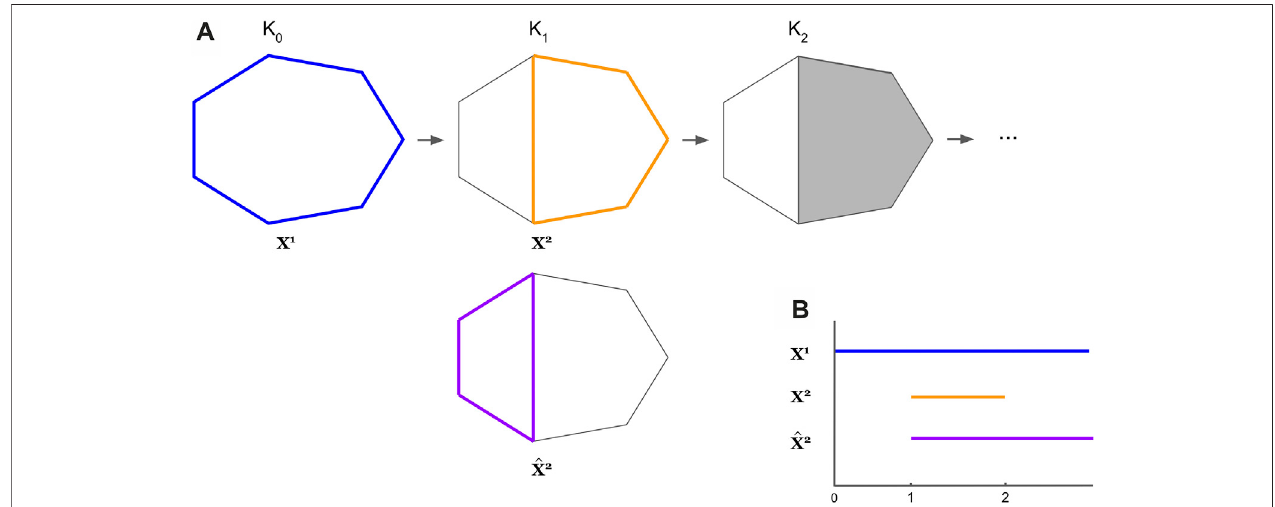
FIGURE 4 | An example where the optimal cycles obtained from Eq. 8 do not form a persistent homological cycle basis. The thickened colored cycles in Sub fi gure (A) represent a cycle representative for the hole it encloses, and the bar with the corresponding color in Sub fi gure (B) records the lifespan of the cycle. In Sub fi gure (A) , we see L ( x 1 ) (cid:2) [ 0 , ∞ ) , L ( x 2 ) (cid:2) [ 1 , 2 ) Then, { x 1 , x 2 } formsabasisforthepersistenthomologicalcycles.Thecyclerepresentative (cid:9) x 2 isanoptimalcyclerepresentativeobtainedbysolving Eq. 7 for the fi ltered simplicial complex K 2 . However, L ( (cid:9) x 2 ) (cid:2) [ 1 , ∞ ) , and thus { x 1 , (cid:9) x 2 } is no longer a persistent homological cycle